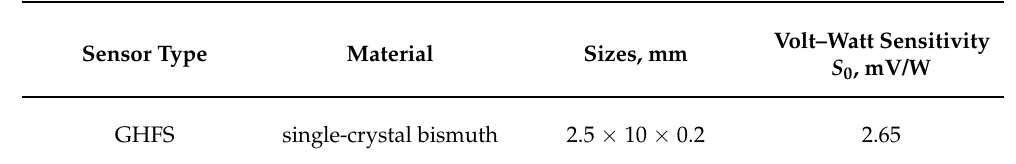
Figure 6. The experimental model. Table 3. GHFS specifications.